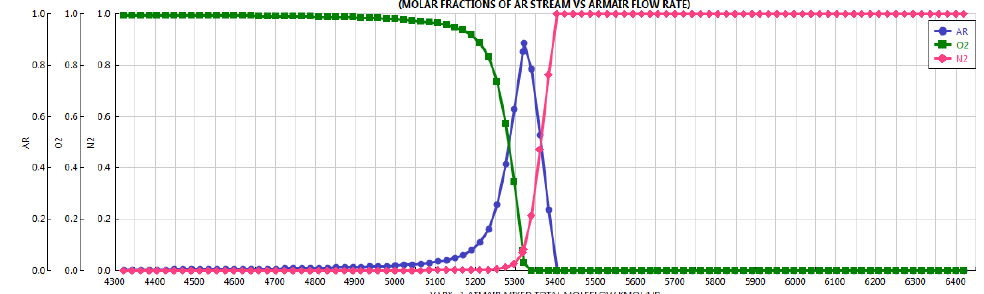
Figure 8. ARO2RECT molar fractions vs. ATMIR mole flow rate.